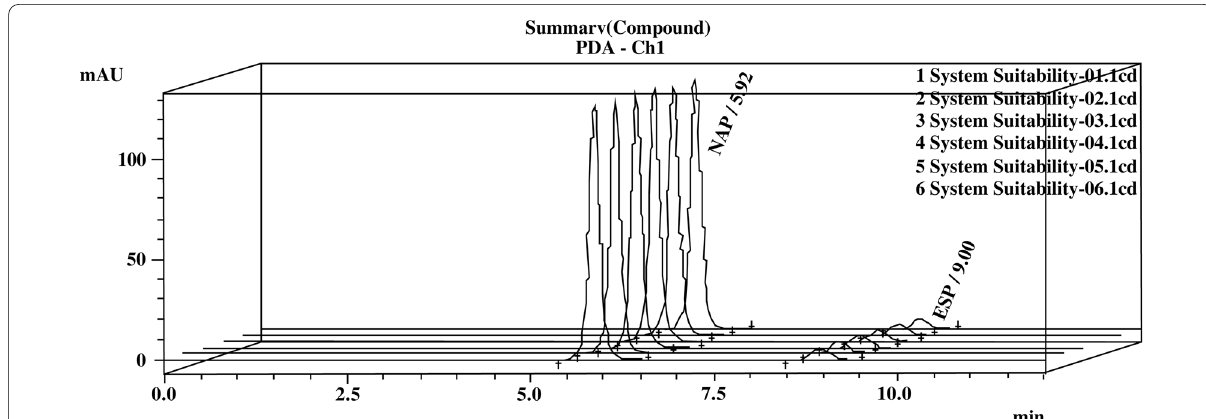
Fig. 5 Chromatographic data for system